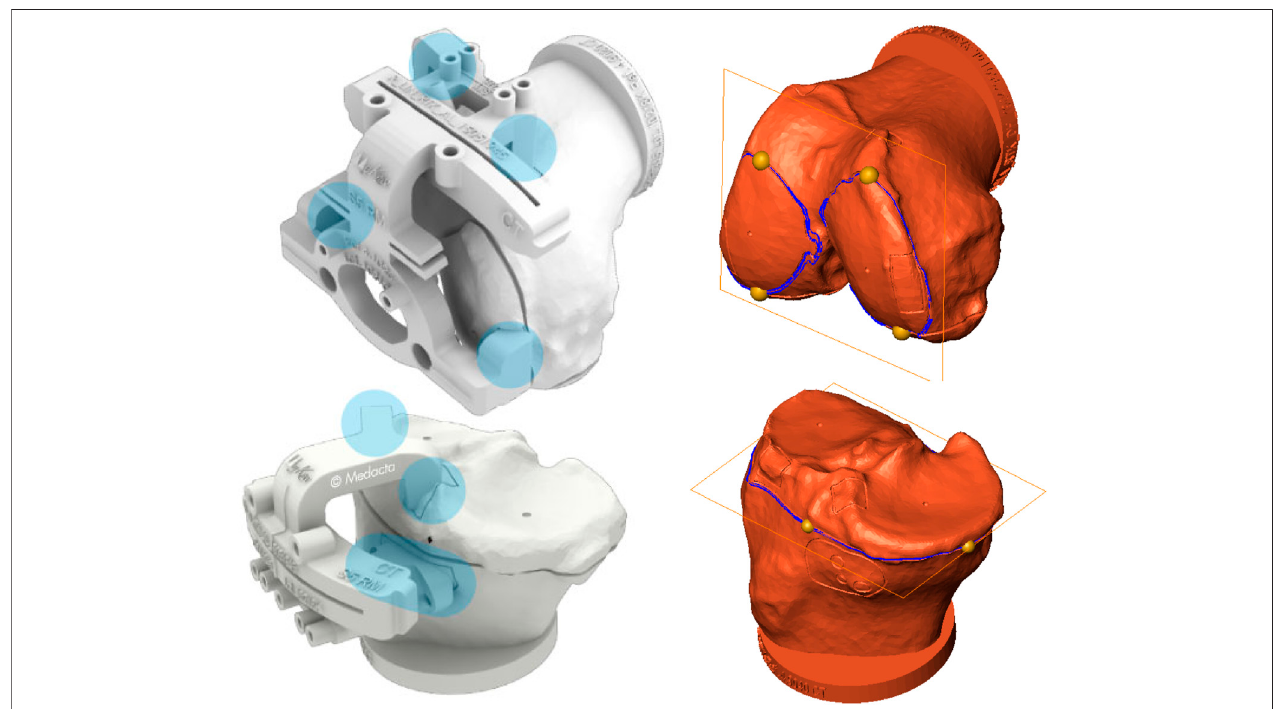
FIGURE 4 | Left: Femoral and tibial PSI of MyKnee system (courtesy of Medacta International SA) with the contact areas highlighted in light blue. As it can be appreciated, the main contact femur areas are at distal condylar level. Likewise, tibial contact areas are located at the plateau mainly. Right: Planning surfaces for case #184 with distal femoral and proximal tibial cutting planes. Four yellow landmarks, taken on the cutting pro fi les (blue curves) of the two planning surfaces, were mapped on the reconstructed surfaces for estimating the corresponding cutting planes and compute angular deviations.